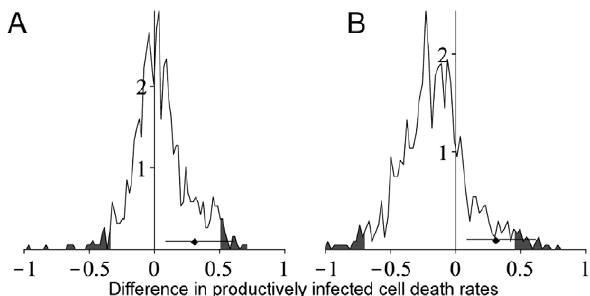
Figure 3. Distribution of the difference in death rate between depleted and control animals. A) early chronic infection, B) late chronic infection. These distributions represent the difference in short- lived productively infected cell death rates which are supported by the experimental data; the grey shading is the 2.5% tails. The distributions are approximately centred on zero i.e. the most likely scenario is that there is no difference in death rates of infected cells between control and depleted animals. However, the distributions are broad and large differences in the death rates, up to and including the differences which would be expected if all CD8 + T cell control was via a lytic mechanism, are also supported by the data. The filled symbol and horizontal lines represent the mean and 95% confidence interval of the difference in death rates if all CD8 + T cell mediated control was via a lytic mechanism (mean=0.3d 2 1 ). A: mean difference=0.05d 2 1 95% CI: 2 0.33d 2 1